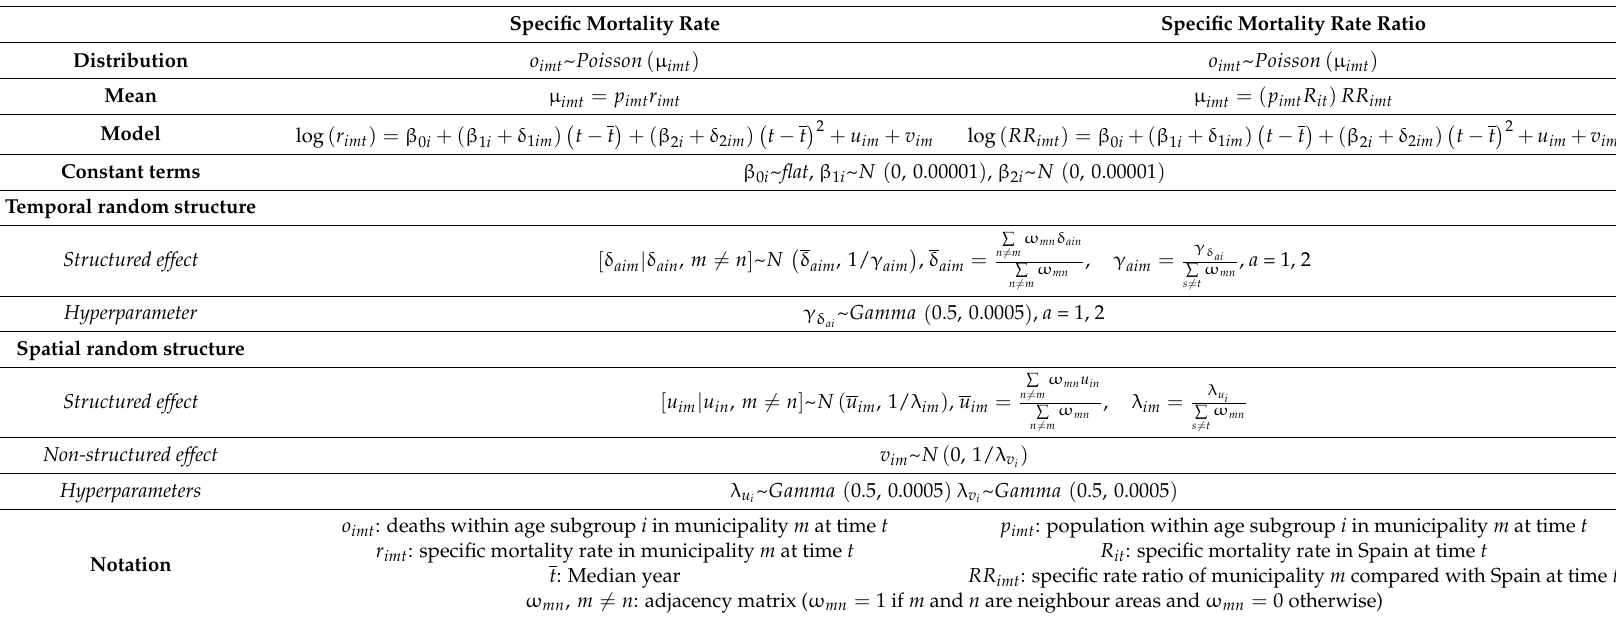
Table 1. Modelling spatio-temporal distribution of mortality from female breast cancer in small-areas of Andalusia (southern Spain). Specific Mortality